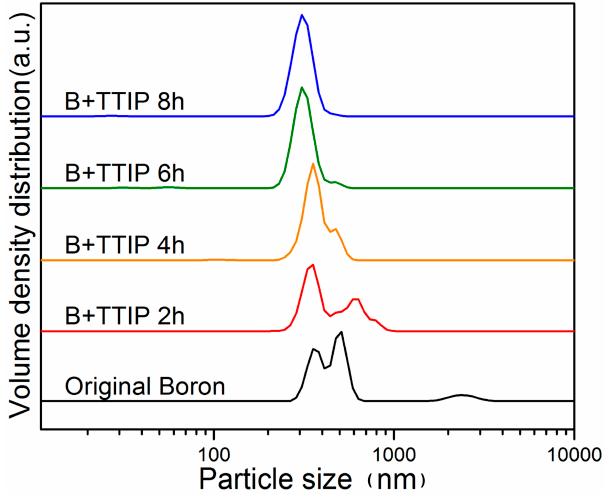
Figure 4. Particle size distributions of bare boron and B + titanium isopropoxide (TTIP) (2, 4, 6, and 8 h) samples measured by nanoparticle size analysis (NPSA).